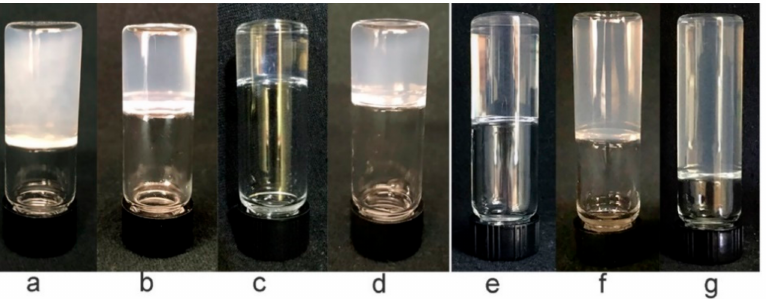
Figure 2. Representative gels formed by compounds 6 , 7 , 11 , 12 in 1-dram vials ( a – d ) and 13 in 2-dram vials ( e – g ). ( a ) shows an opaque gel, ( b ) and ( d ) show translucent gels, the rest are transparent gels. ( a ) 6 in EtOH/H 2 O (1:1) at 0.74 mg/mL; ( b ) 7 in DMSO/H 2 O (1:1) at 0.91 mg/mL; ( c ) 11 in EtOH/H 2 O (1:1) at 2.2 mg/mL; ( d ) 12 in EtOH/H 2 O (1:2) at 0.91 mg/mL; ( e – g ) compound 13 , ( e ) EtOH/H 2 O (1:1) at 0.54 mg/mL; ( f ) H 2 O at 0.40 mg/mL; ( g ) EtOH/H 2 O (1:2) at 0.36